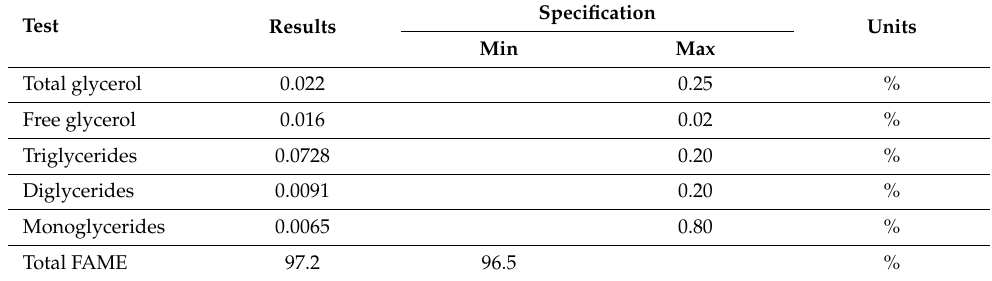
Table 11. Results of gas chromatography.